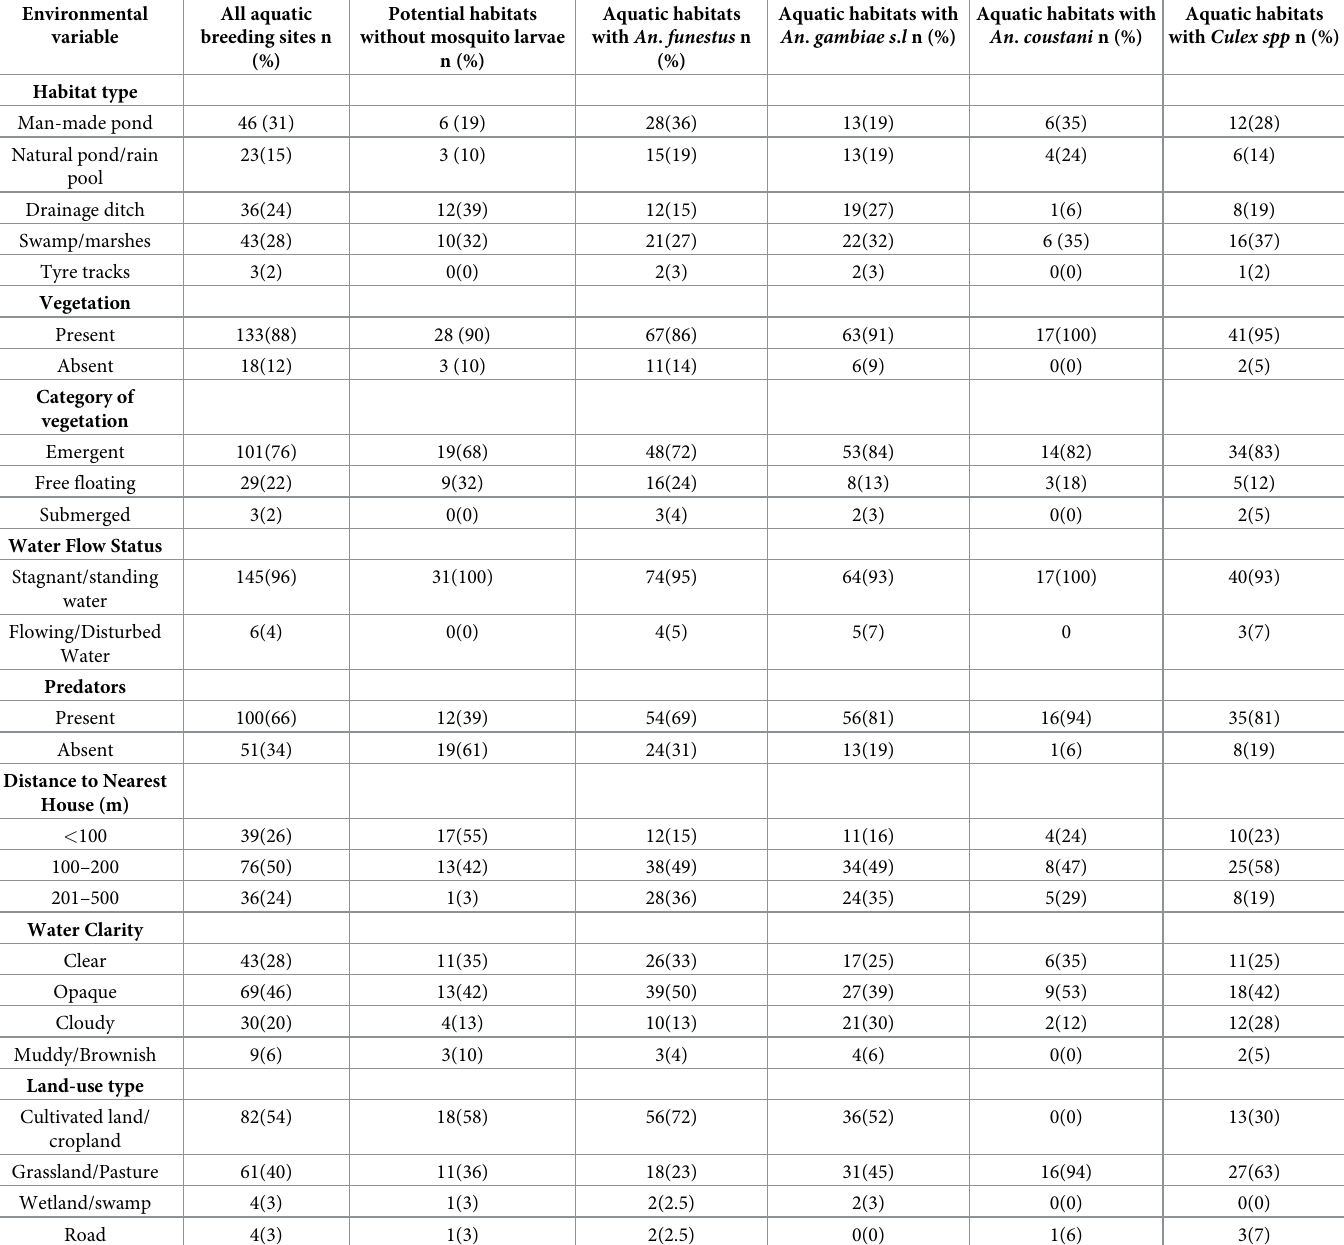
Table 2. Characteristics of aquatic habitats of An . funestus and other mosquito species at Bungoma and Kombewa western Kenya (November 2019-November, 2020). Environmental